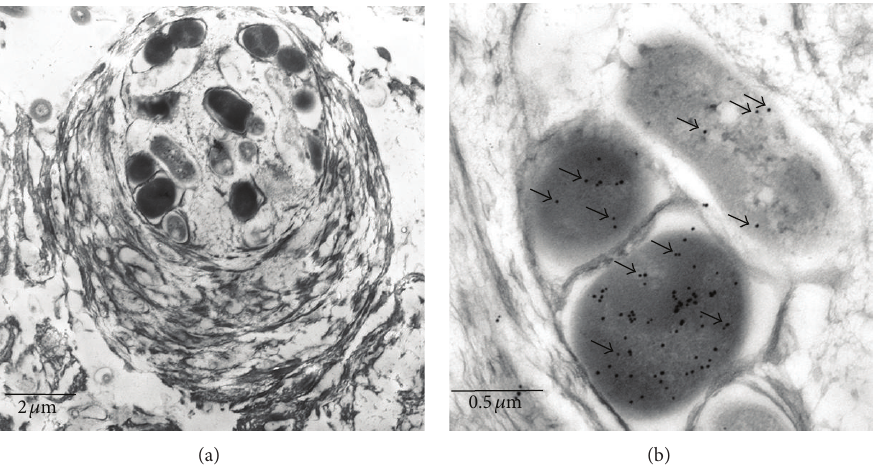
Figure 2: Immunoelectron microscopy. (a) Electron microscopy of a typical small aggregate (cf. Figure 1(c)), consisting of ANME-2/SRB. Several single cells are surrounded by a thick multilayered mucilage. (b) Detail of the aggregate as depicted in (a). The MCR expressing ANME-2 cells are labelled with small gold dots (black arrows point to some dots); the SRB (upper right cell) show a low background labelling (black arrows).